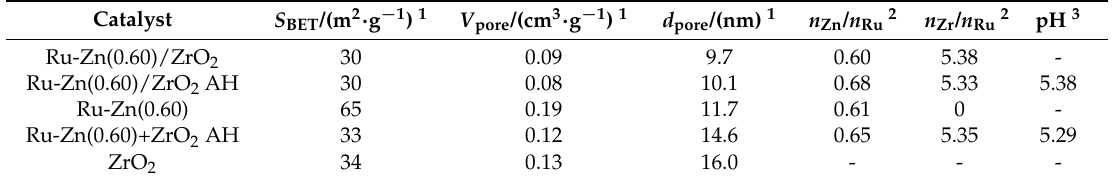
Table 2. Texture properties and composition of the supported Ru-Zn(0.60)/ZrO 2 catalyst and the unsupported Ru-Zn (0.60), as well as the pH values of the slurry, after hydrogenation.